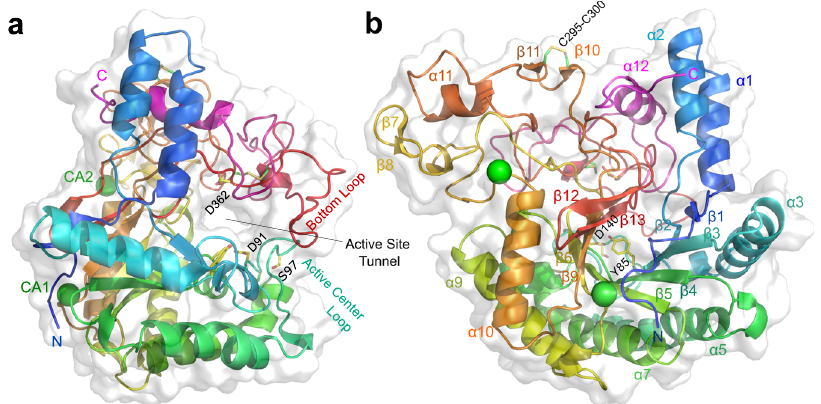
Fig. 3 Crystal structure of HmCel6A. a , b Two views (in ribbon representation) of the Ca 2 + -bound structure. The protein chain is blue to red from the N- to C-terminus. Calcium ions, CA1 and CA2, are displayed as green spheres. The active site is enclosed in a tunnel formed by interactions between the extended bottom loop and the active site loop. Catalytically important residues and disulphide bonds are shown in stick representation. a Ribbon representation of HmCel6A overlaid on the Connolly surface representation. b View showing the β / α barrel structure with a central β -barrel